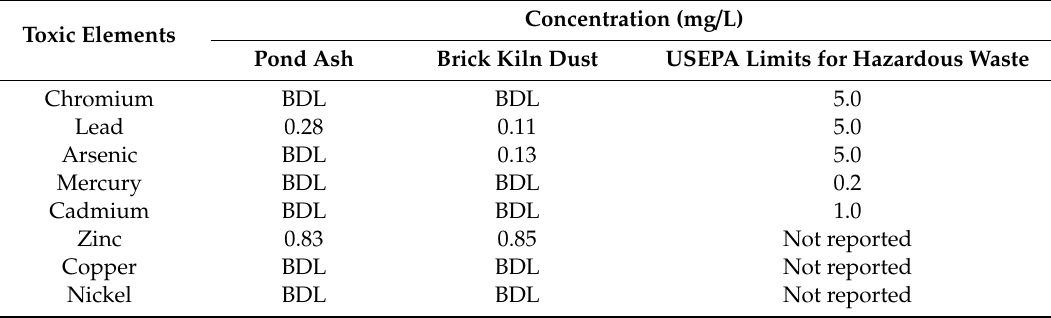
Table 6. Concentration of toxic elements present in pond ash and brick kiln dust.